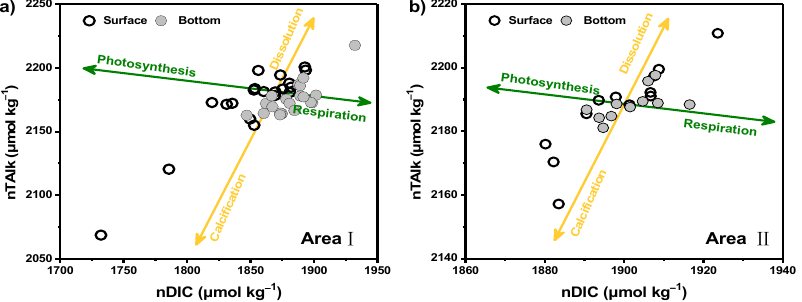
Figure A6. The nTAlk versus nDIC in the surface and bottom water of Yangmeikeng Sea Area (Area I) ( a ) and Dalu Bay (Area Ⅱ ) ( b ). Vectors illustrate the directions of the effects of photosynthesis, respiration and calcification on TAlk and DIC. The data of Area I ( n = 42) and Area Ⅱ ( n = 22) were normalized to salinity of 32.44 and 32.57, respectively. Surface (Area Ⅰ ) Bottom (Area Ⅰ ) Surface (Area Ⅱ ) Bottom (Area Ⅱ )